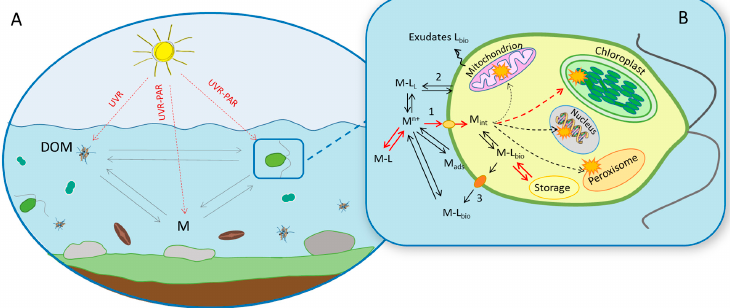
Figure 2. Effect of the light irradiation on the interactions of trace metal (M) with dissolved organic matter (DOM) and photosynthetic microorganisms. ( A ) Photo-synthetically active radiation (PAR) and ultraviolet radiation (UVR) influence directly photosynthetic microorganism and their interaction with trace metals and exudates production. UVR might transform DOM and alter chemical speciation and bioavailability of metals. Light might also affect metal speciation directly via photoreactions and changing metal oxidation state. The bioavailable metals might be toxic to photosynthetic organisms and affect their photosynthetic activity. ( B ) Processes at cell-ambient medium interface determining metal bioavailability and intracellular fate in eukaryotic algae: (1) active transport; (2) passive transport; (3) efflux; M n+ metal ion; M-L metal complexes with ligands; M ads metal adsorbed to the cell surface; M int intracellular metal; L bio biological ligand. To exert an effect both vital and toxic metals have first to interact with the microorganism surface and enter the cells by different mechanisms. Metal ions that reached the intracellular environment might or might not have a toxic action to the microorganism. Cells have evolved several response mechanisms confering protection in case of excess of intracellular metal quota [16]. Metals can be excreted or remain in the intracellular environment where they can be either sequestrated by metal complexing ligands or transported to specific subcellular compartments and stocked in Ca-phosphate granules [17,18]. When the intracellular content exceeds the ability of the cells to maintain homeostasis, toxic effects are observed. Changes in light radiation can affect different toxicokinetics and toxicodynamics processes. The processes known to be affected by light are given in red. No information available concerning the possible effects of light on the other processes. Various environmental factors, including light, might influence metal speciation and bioavailability [2,4], as well as the microorganism “state” and consequently affect the metal uptake and the associated cellular effects [4]. Light radiation is one of the most variable environmental parameters. The light intensity and spectral composition change on a daily scale and depend on cloud